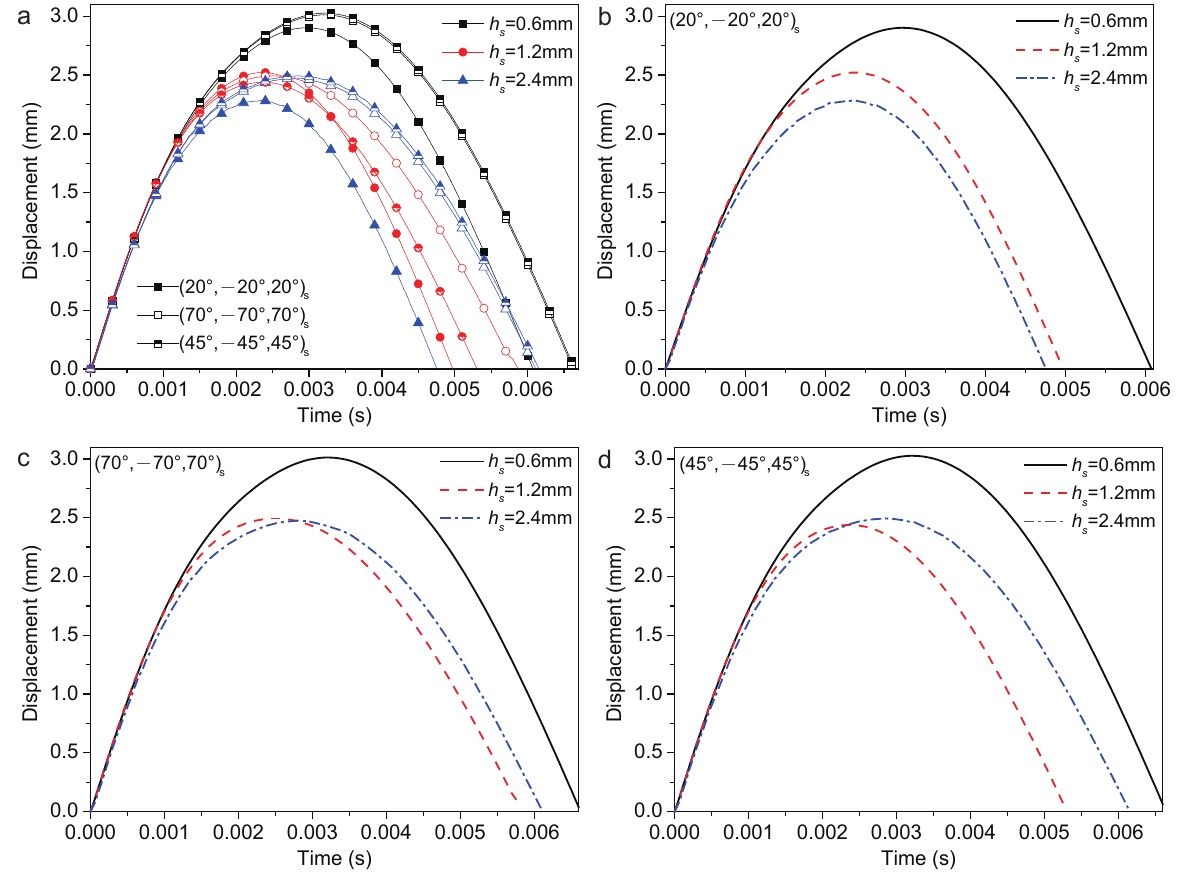
Figure 13. Plate center displacement response of the sandwich structure with various h s : ( a ) FG-O, UD and FG-V face sheets plate; ( b ) (20/ − 20/20)s plate; ( c ) (70/ − 70/70)s plate; and ( d ) (45/ − 45/45)s